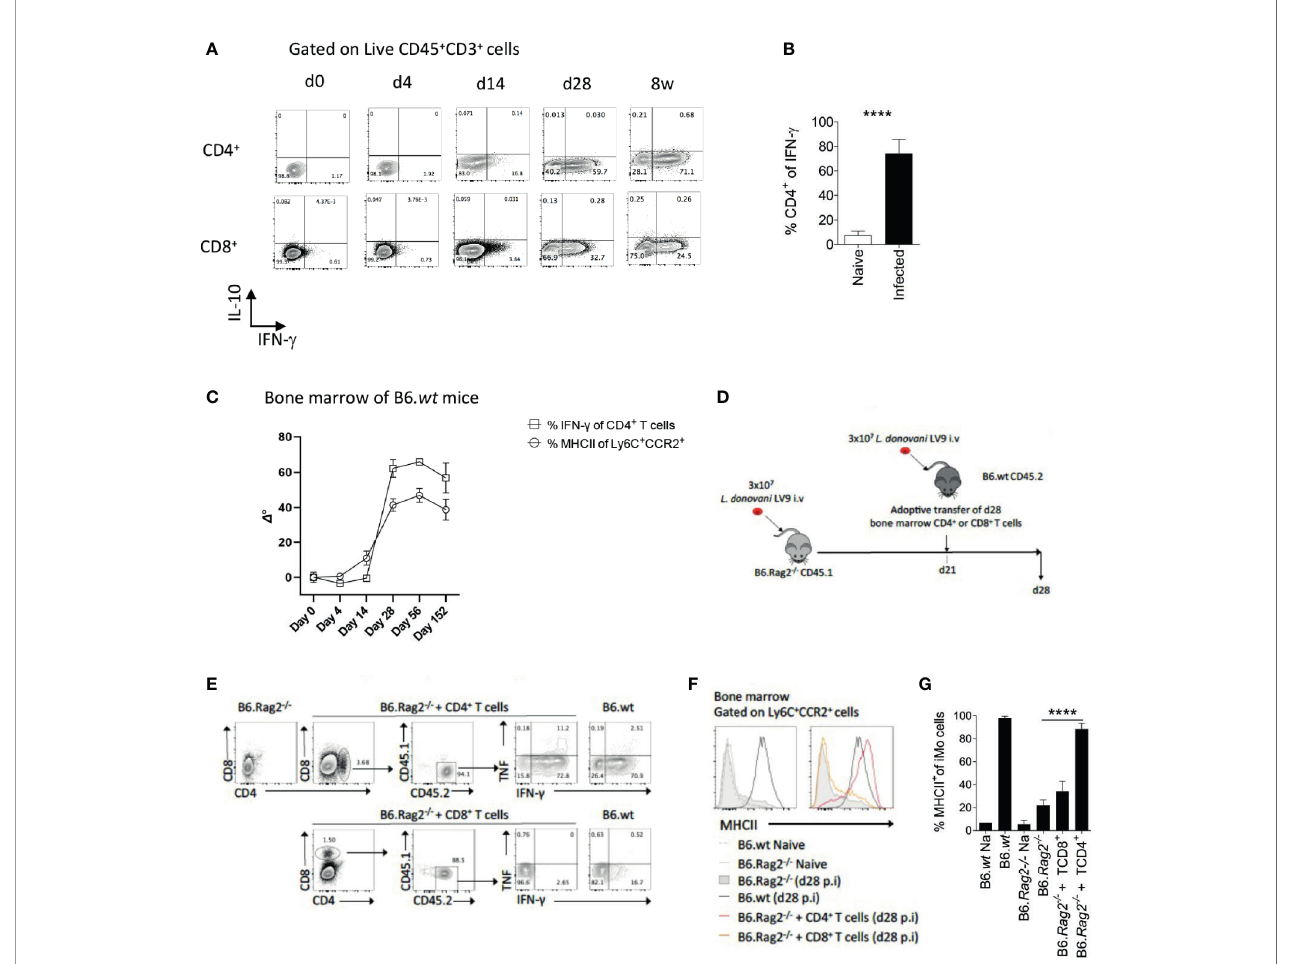
FIGURE 2 | CD4 + T cells are the main producers of IFN g in the bone marrow of B6 mice and contribute to local monocyte activation. (A) Dot plot indicating representative expression of IL-10 and IFN g by CD3 + CD4 + T cells at different time points p.i. Cells were stimulated with PMA/Ionomycin. (B) Percentage of CD4 + T cells expressing IFN g . Welch ’ s t test applied: P<0.0001 (****); 95% CI: 38.89 – 51.63; statistical power: 100%; n ≥ 4. (C) IFN g expression by BM CD4 + T cells and MHCII expression on Ly6C + CCR2 + monocytes. Data was normalized by subtraction of d0 mean after arcsin conversion, respectively. (D) Protocol for adoptive transfer of T cells. (E) Cytokine production by adoptively transferred BM CD4 + or CD8 + T cells 1 week post transfer into recipient L. donovani -infected B6. Rag2 -/- mice. Cells were stimulated with PMA/Ionomycin. (F, G) MHCII expression on Ly6C + CCR2 + monocytes in the BM of the mice one week post adoptive T cell transfer, shown as histogram plots (F) and percentage (G) . Data are derived from analysis of 3 to 4 individual mice of each strain per group and are shown as mean ± SD. Data are pooled from 2 independent experiment. Brown-Forsythe ANOVA applied in (G) without group B6. wt NA: P<0.0001 (****); statistical power: 100%; n ≥ 4; post hoc test Dunnett ’ s T3, the different pairwise comparisons are shown in Table S1 . Data in (E, F) are representative